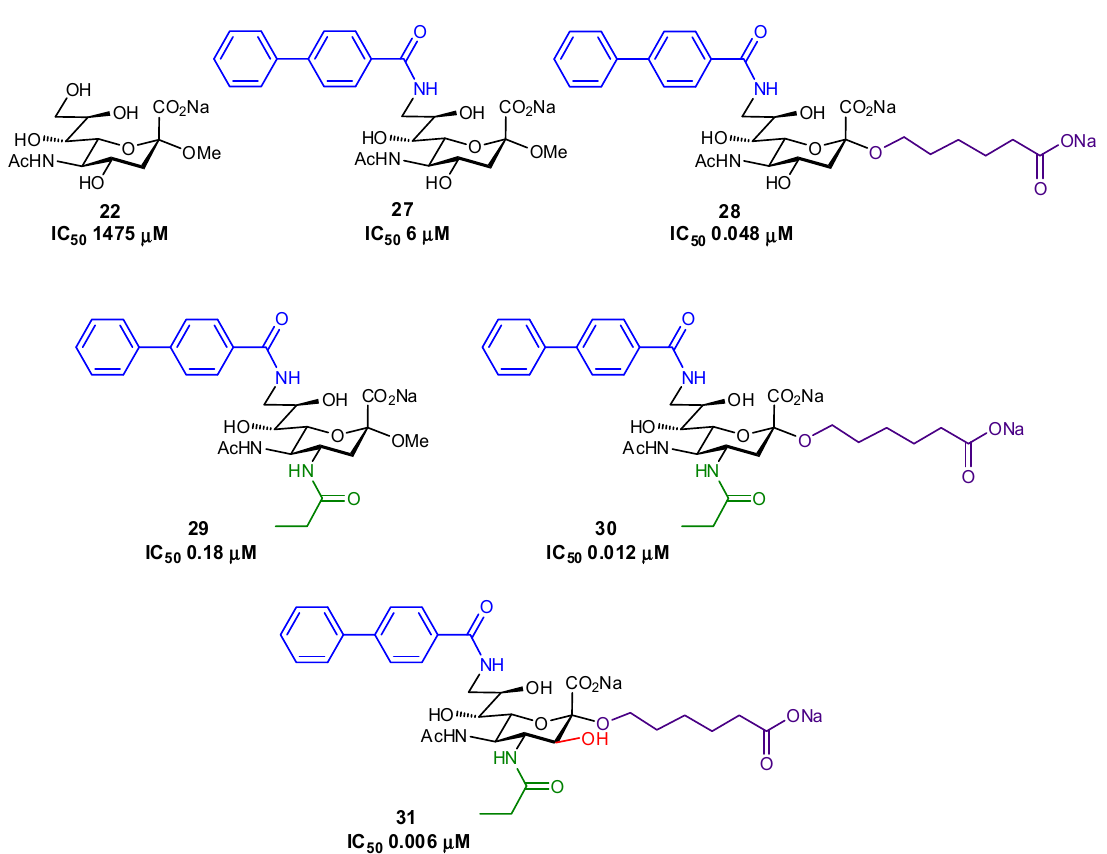
Figure 9. High-affinity inhibitors of Siglec-2 generated through C-2, C-4, and C-9 modification of sialic acid [70].